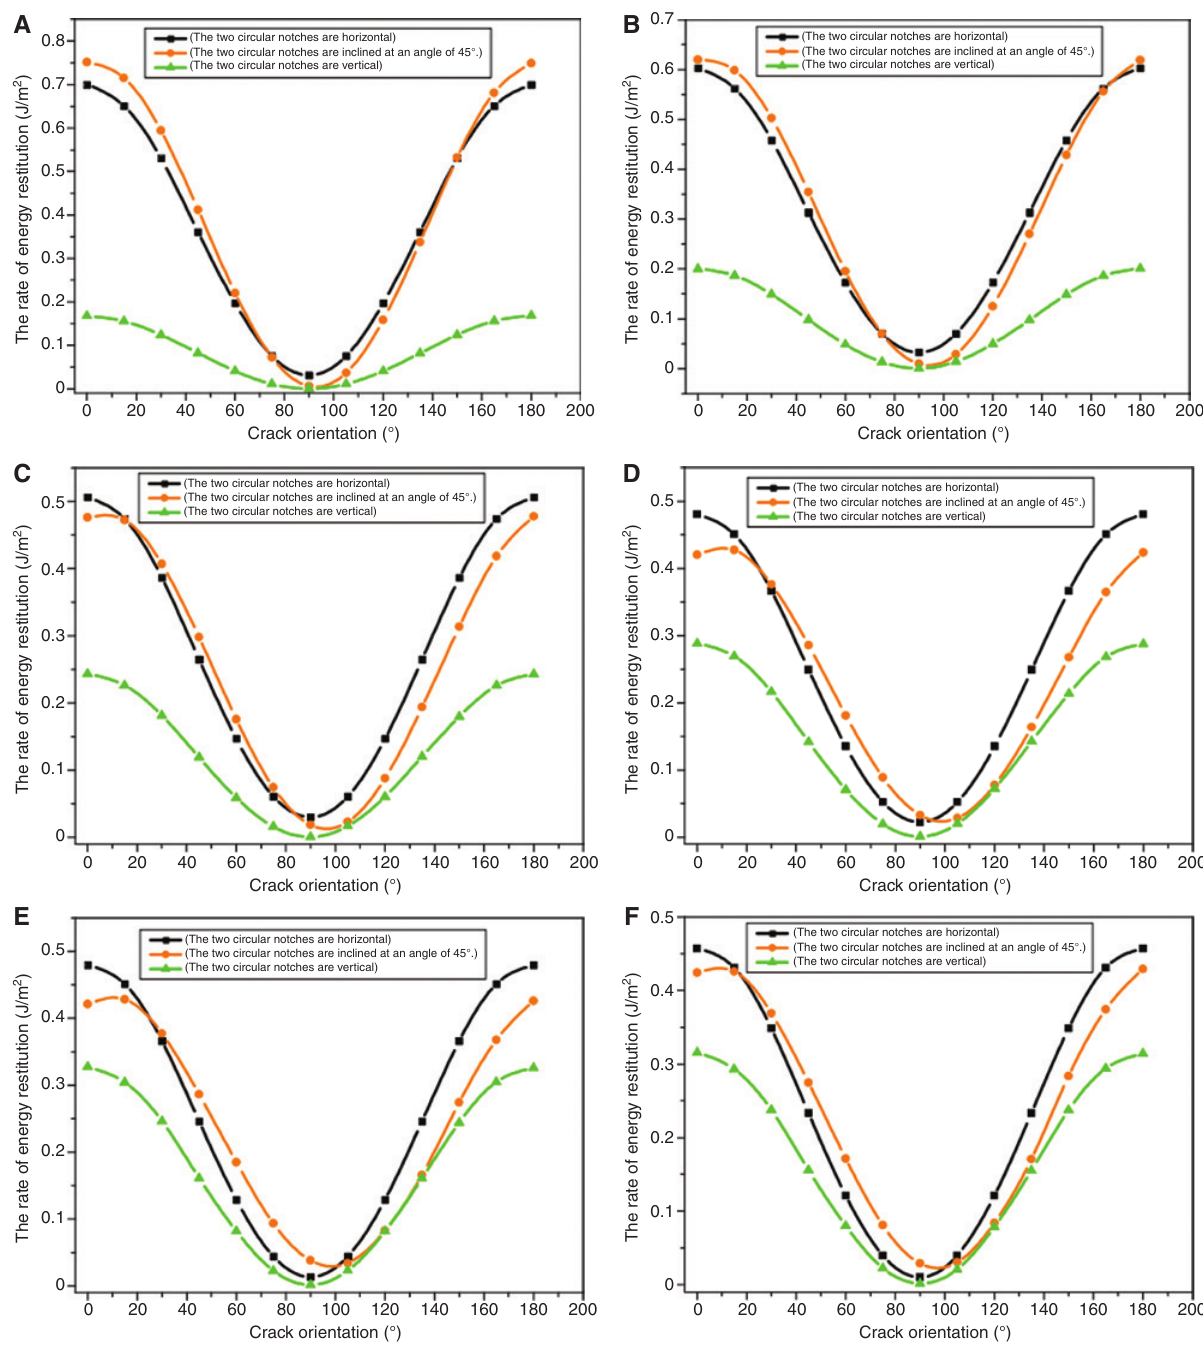
Figure 14: Variation in the rate of energy restitution in function on the orientation of the crack for the three positions of the circular notches and different fiber